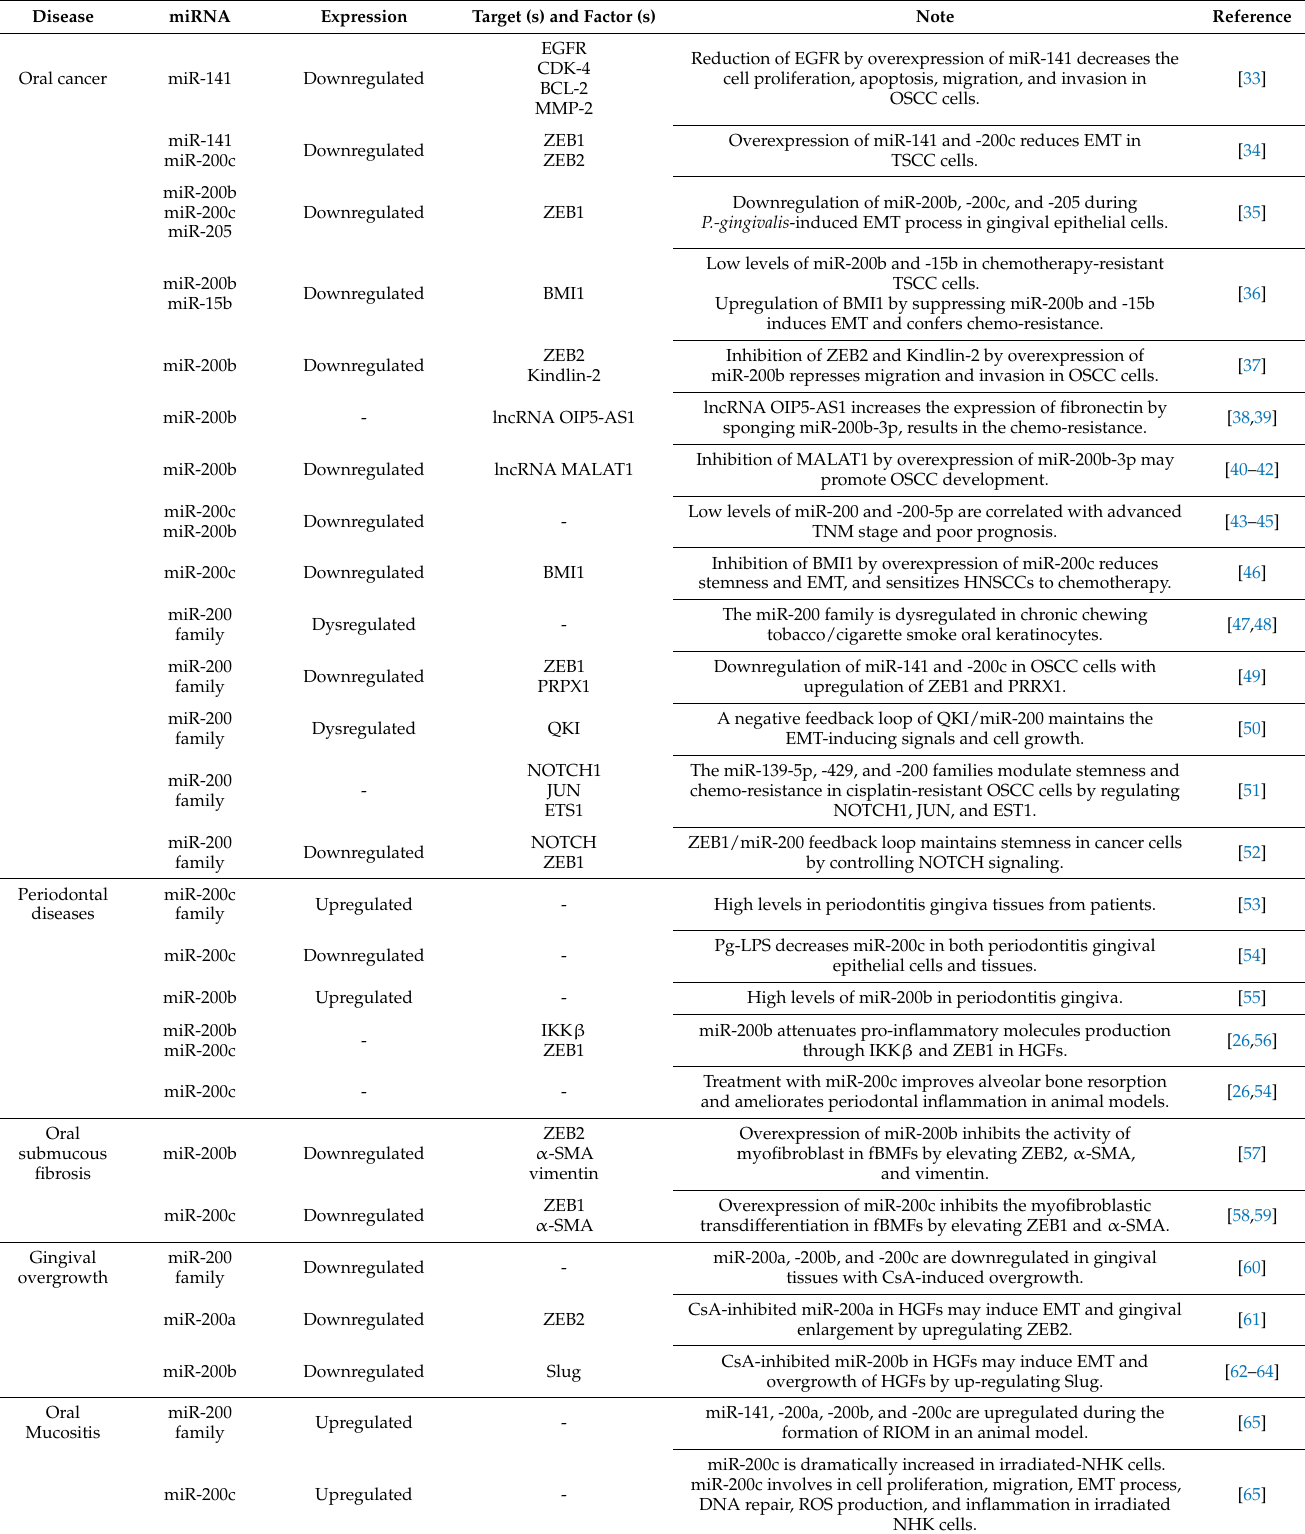
Table 1. The expression of the miR-200 family in